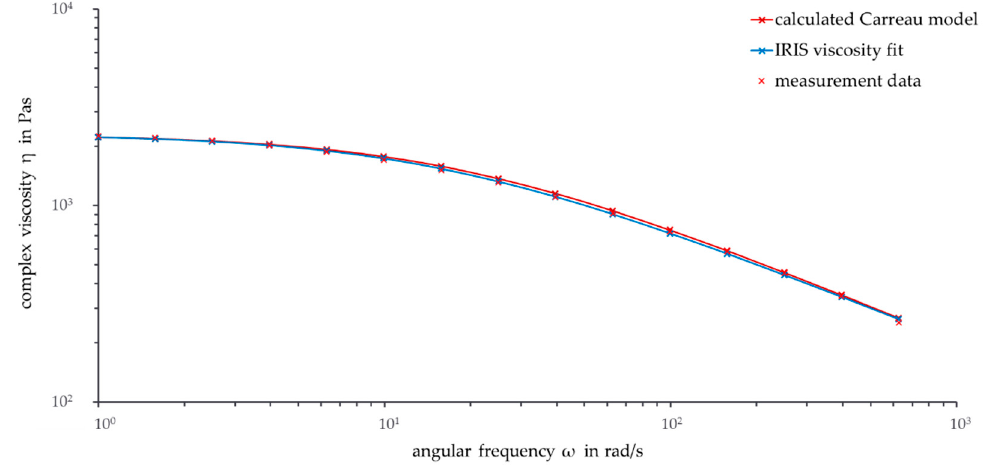
Figure 4. Frequency sweep: Calculated Carreau model, IRIS viscosity fit, and measurement data from reference temperature ( ϑ = 180 °C, ω = 1–628 rad/s).